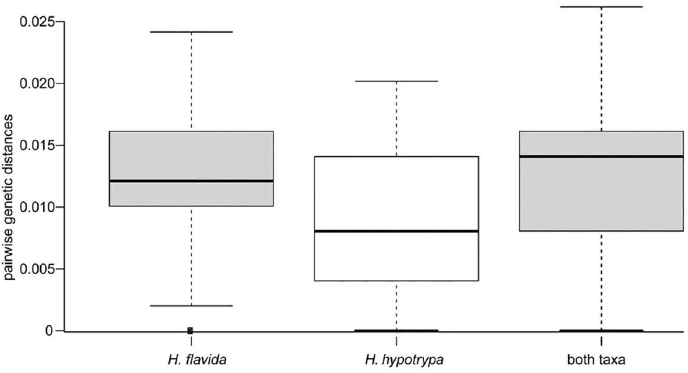
Fig 3. Box plot representation of the intra- and interspecific pairwise genetic distances for the Hypogymnia hypotrypa group. In each box plot, the box shows the interquartile range (IQR) of the data. The IQR is defined as the differencebetween the 75th percentileand the 25th percentile.The whiskers represent variabilityoutside the upper and lower quartiles. The solid line through the box represents the medianpairwise genetic